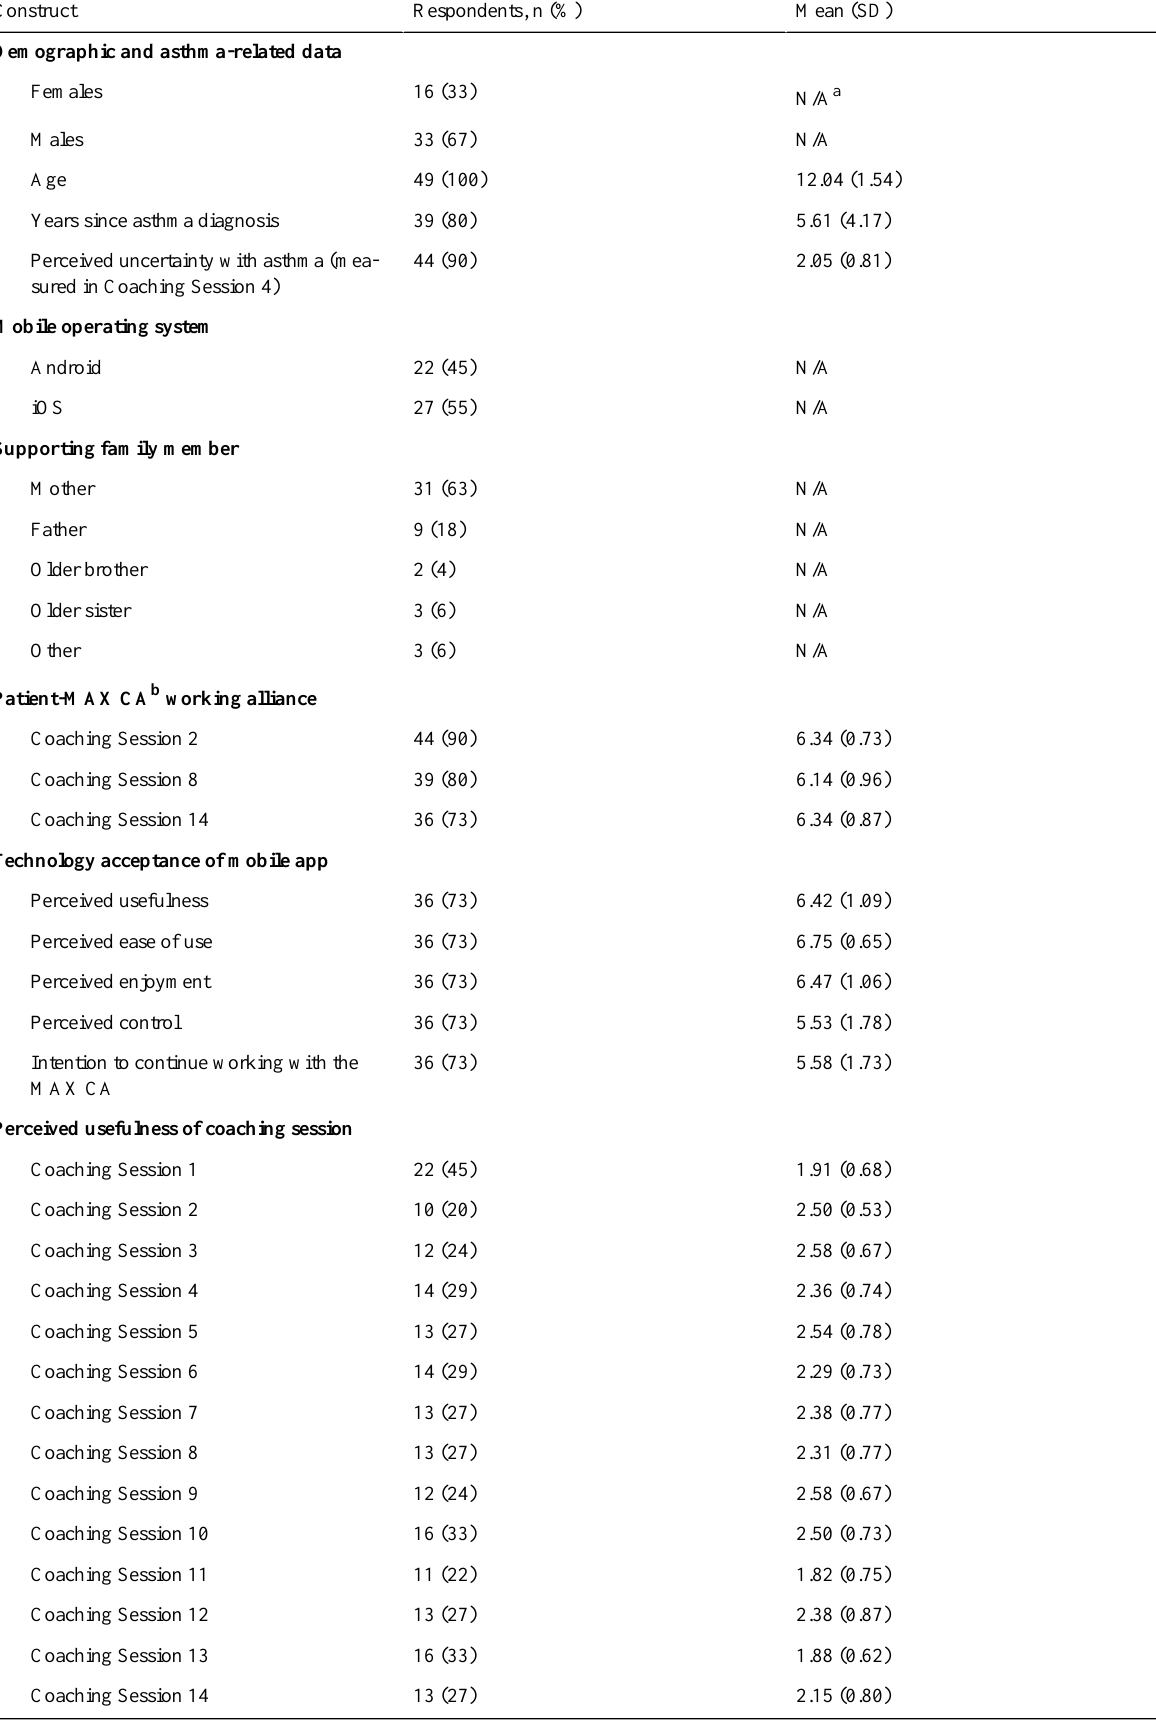
Table 1. Descriptive statistics of the patient-derived quantitative measures